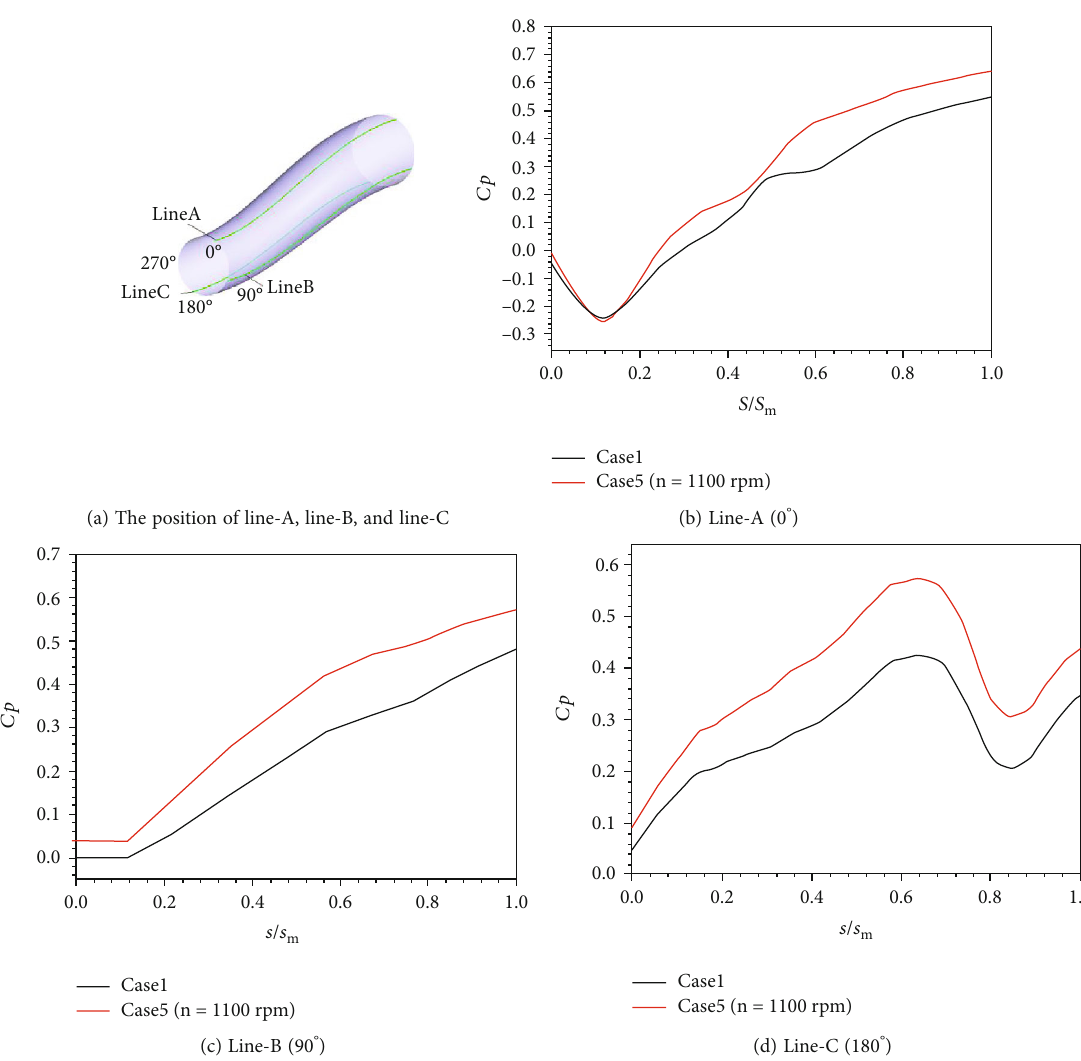
Figure 7: The surface pressure coe ffi cient for the S-shaped intake with/without propeller.